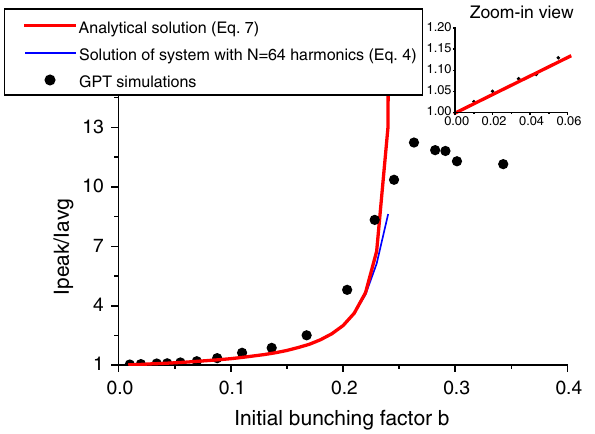
FIG. 1. Nonlinear peak current enhancement as a function of amplitude of initial density modulation. In the inset we show the linear behavior for small initial bunching factor.